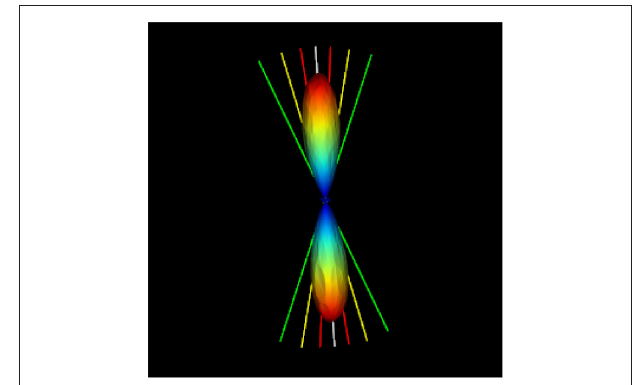
FIGURE 5 | Illustration of the uncertainty alpha parameter at 95% (red), 75% (yellow), and 35% (green) of the maxima. The script to compute these alpha values for each fODF peak is given in the